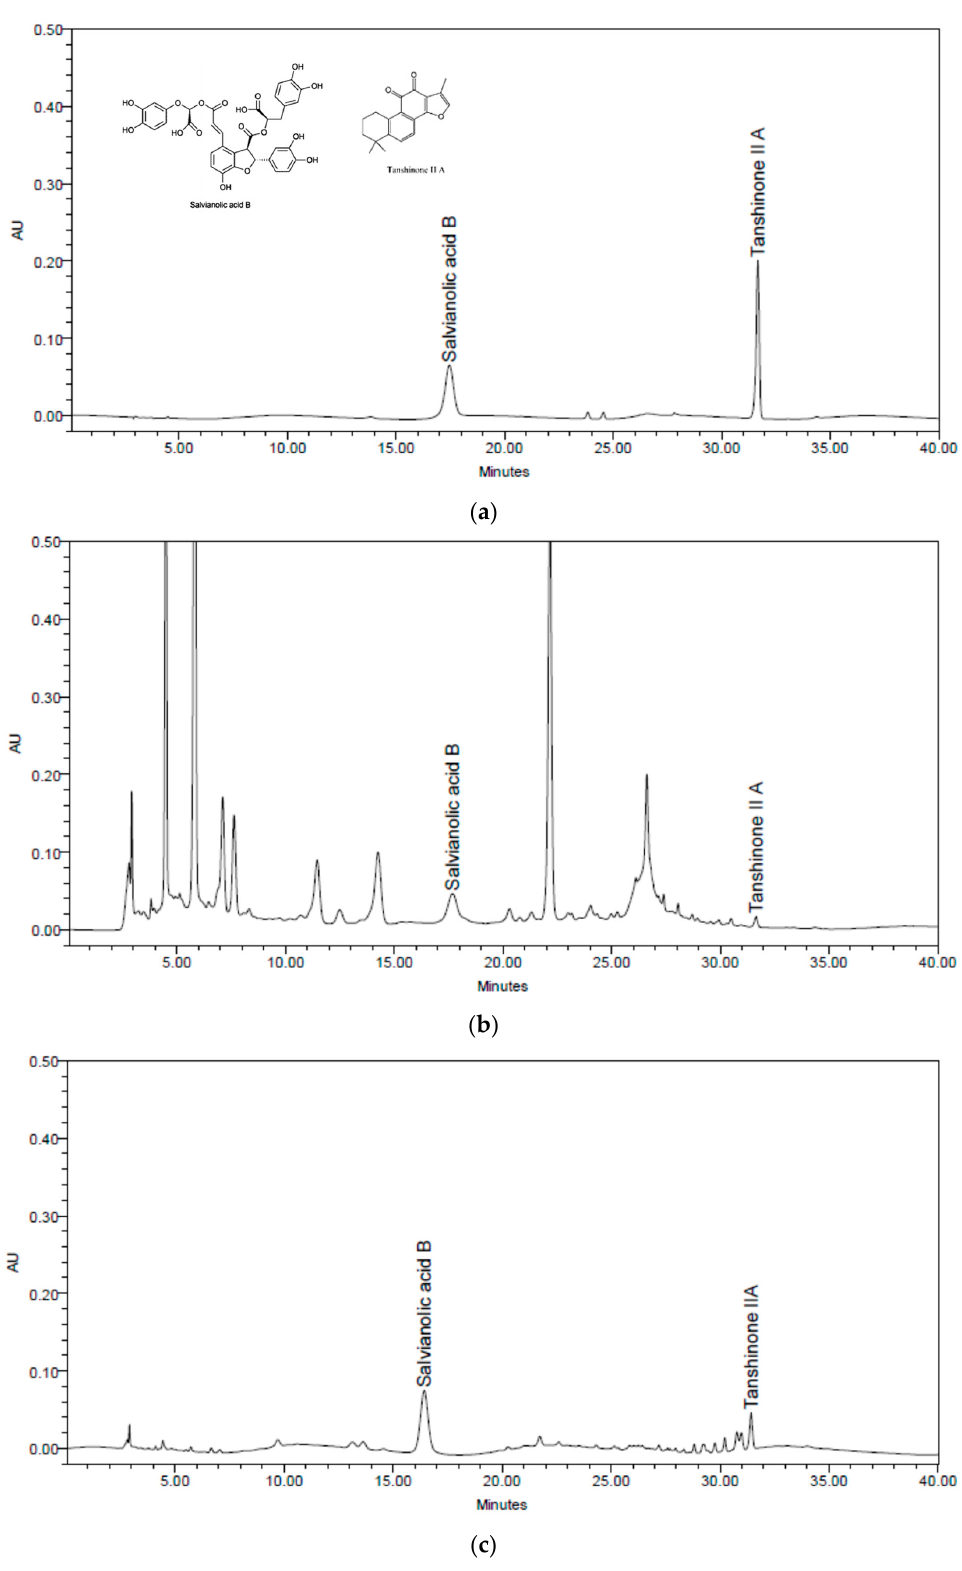
Figure 1. HPLC chromatogram of salvianolic acid B and tanshinone II A. ( a ) A standard mixture of salvianolic acid B, tanshinone II A. ( b ) Cardiotonic pills contained 0.14% of salvianolic acid B and 0.002% of tanshinone II A. ( c ) Sample B contained 2.66% of salvianolic acid B and 0.11% of tanshinone II A.